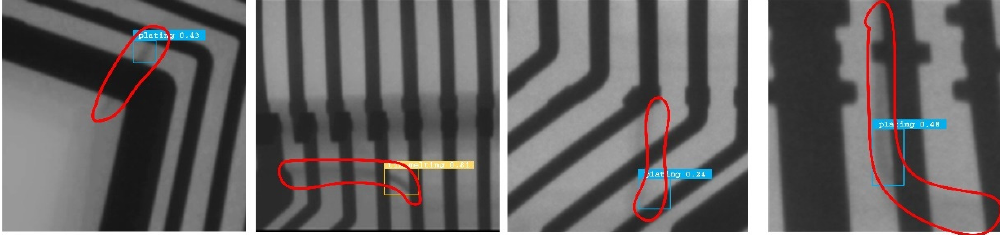
Figure 19. Some examples of typical misjudgments.